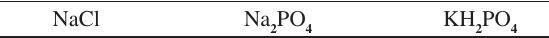
Table 2. Chemical composition (g.L –1 ) of the phosphate buffer solution (PBS), pH = 7.0. NaCl